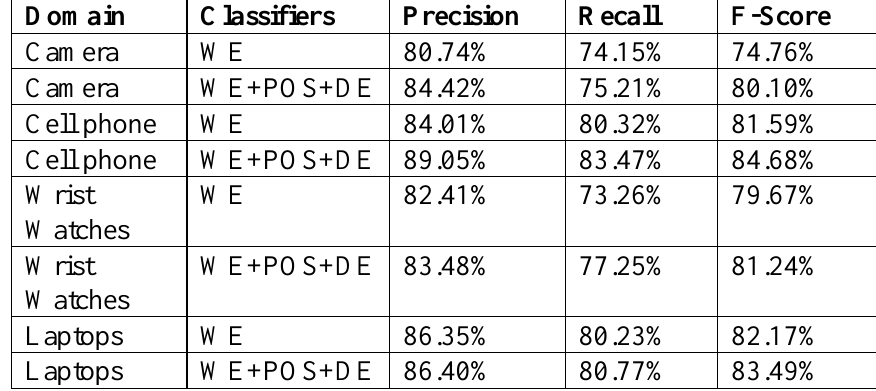
Figure 3: Comparison of the performance with in four domains Table.3: Impact of the POS feature on the